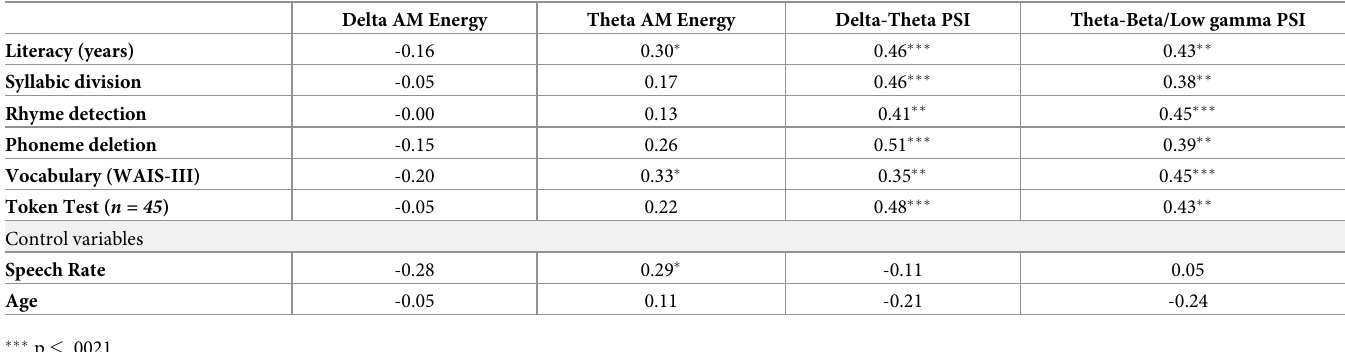
Table 2. Correlations between modulation energy and AM phase synchronisation and the behavioural tests for conversational